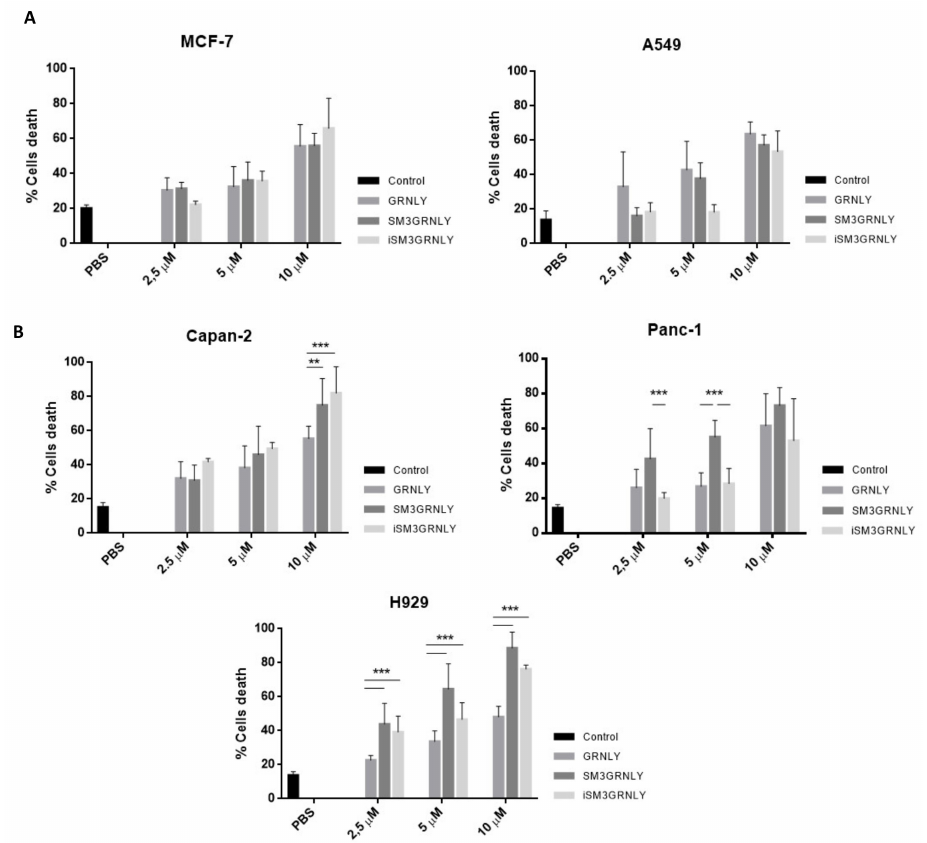
Figure 6. Cytotoxicity of GRNLY and SM3GRNLY on tumoral cell lines. ( A ) A549 or MCF7 cells were incubated with increasing concentrations of recombinant GRNLY, SM3GRNLY or iSM3GRNLY, asindicated, for24h. ( B ),NCI-H929, Capan-2orPanc-1cellswereincubatedwithincreasingconcentrations of recombinant GRNLY, SM3GRNLY or iSM3GRNLY, as indicated, for 24 h. Apoptotic cell death was determinedinallcasesbydetectionofphosphatidylserineexposurebystainingwithAnnexin-Vconjugated with fluorescein isothiocyanate (FITC) and flow cytometry. Basal labelling of cells treated with PBS is also shown as control (black bars). Results are the mean ± SD of at least three different experiments. **, p < 0.01; ***, p <